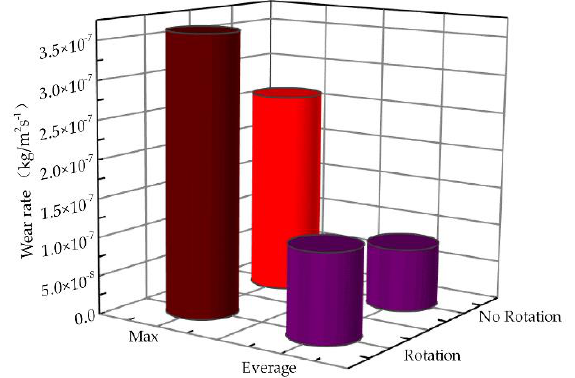
Figure 11. The effect of particle rotation on wear rate along the path.